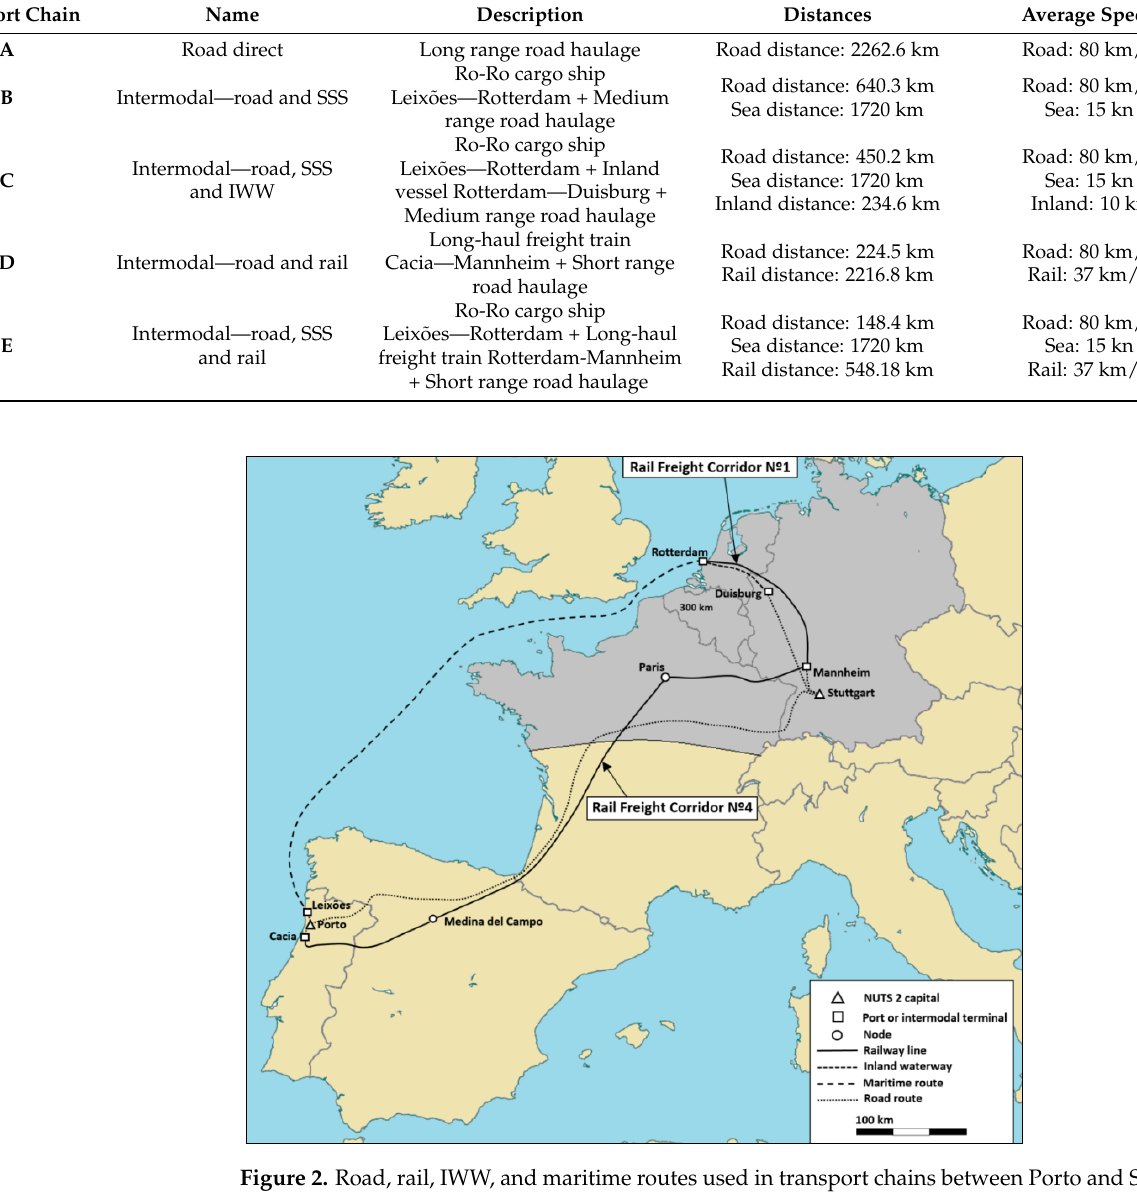
Table 9. Vehicles’ power and fuel and emissions control characteristics in representative emission scenarios.